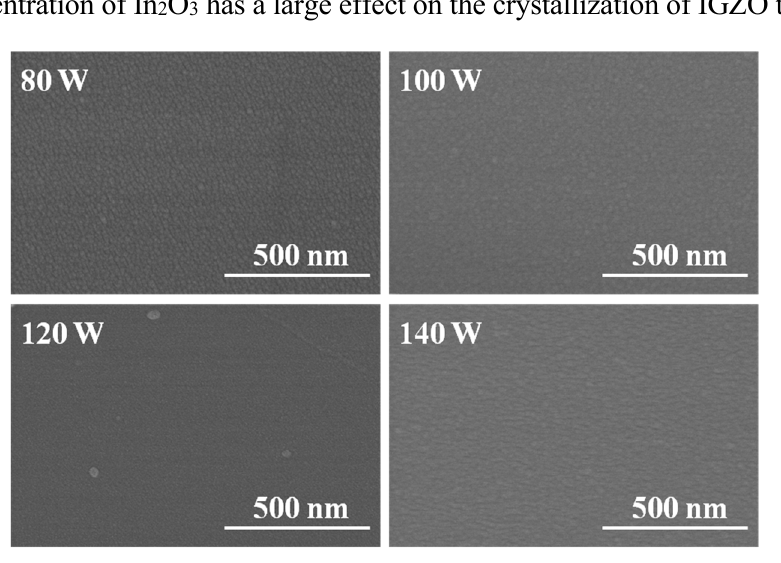
Figure 2. Surface morphology of IGZO thin films as a function of deposition power of GZO ceramic